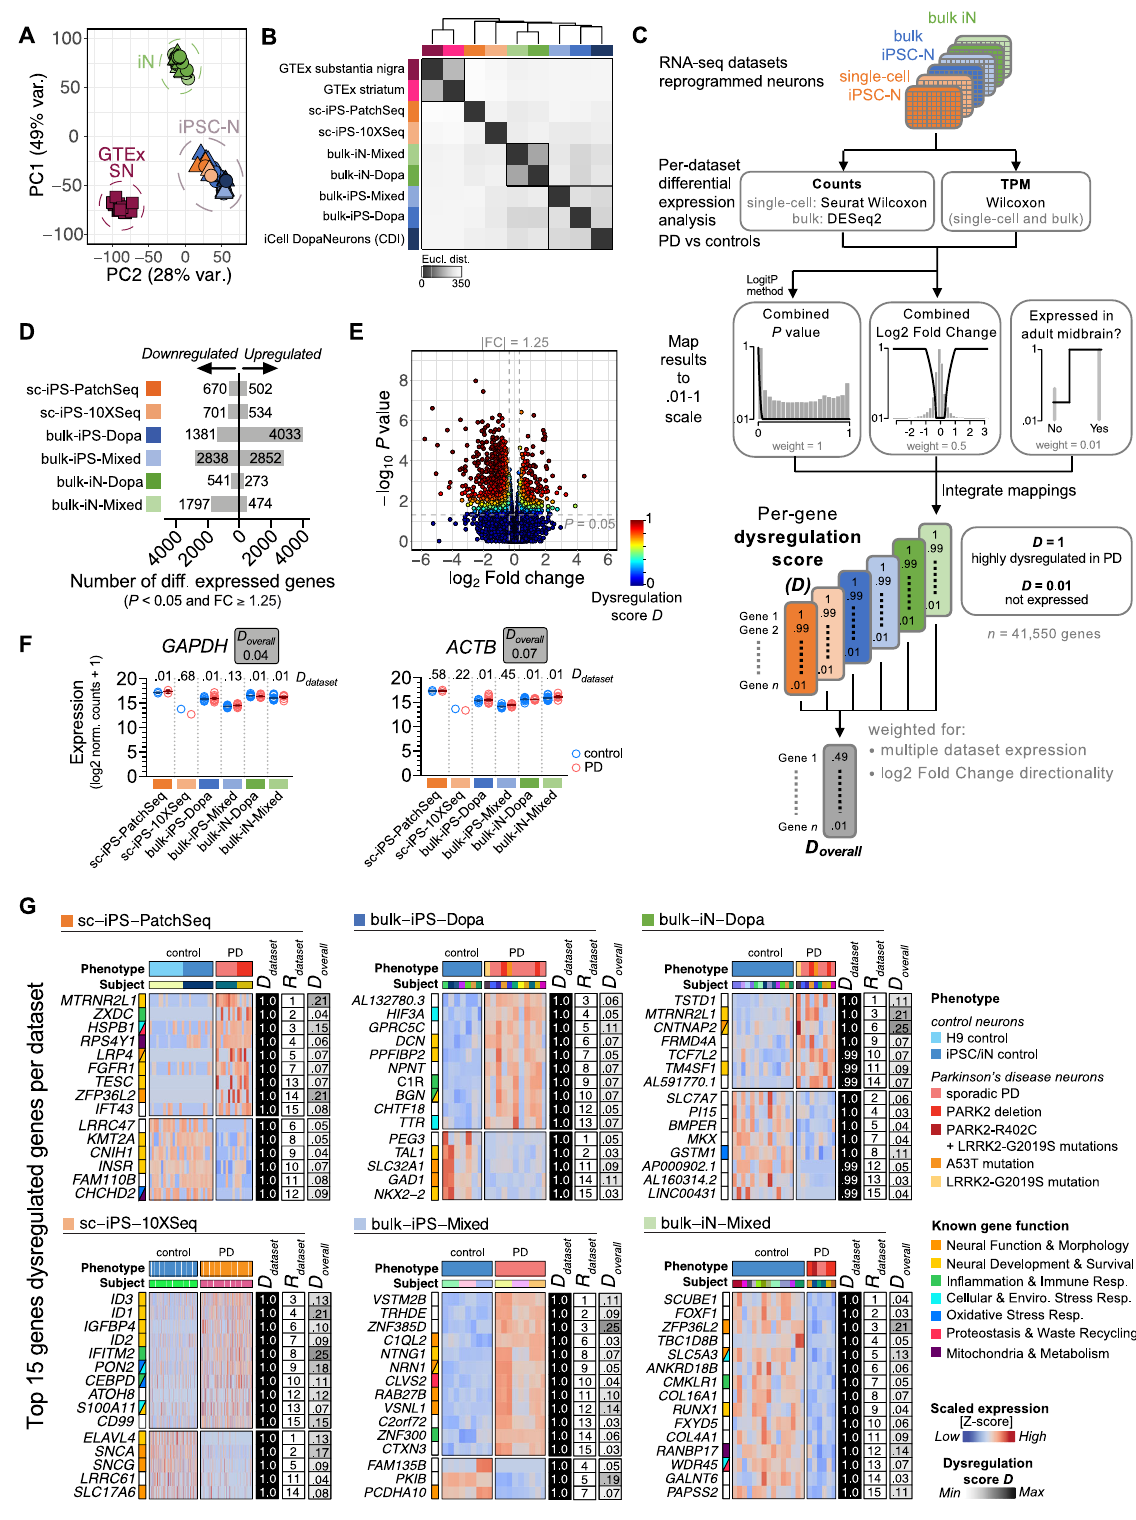
desirability functions 48 and combined by weighted averaging to obtain a dysregulation score ( D ) for each gene. We also adjusted the scores with weighted functions for statistical signi fi cance ( P- value), the magnitude of fold change, and the relevance of the gene in the adult midbrain in vivo (Fig. 2C, see also Methods